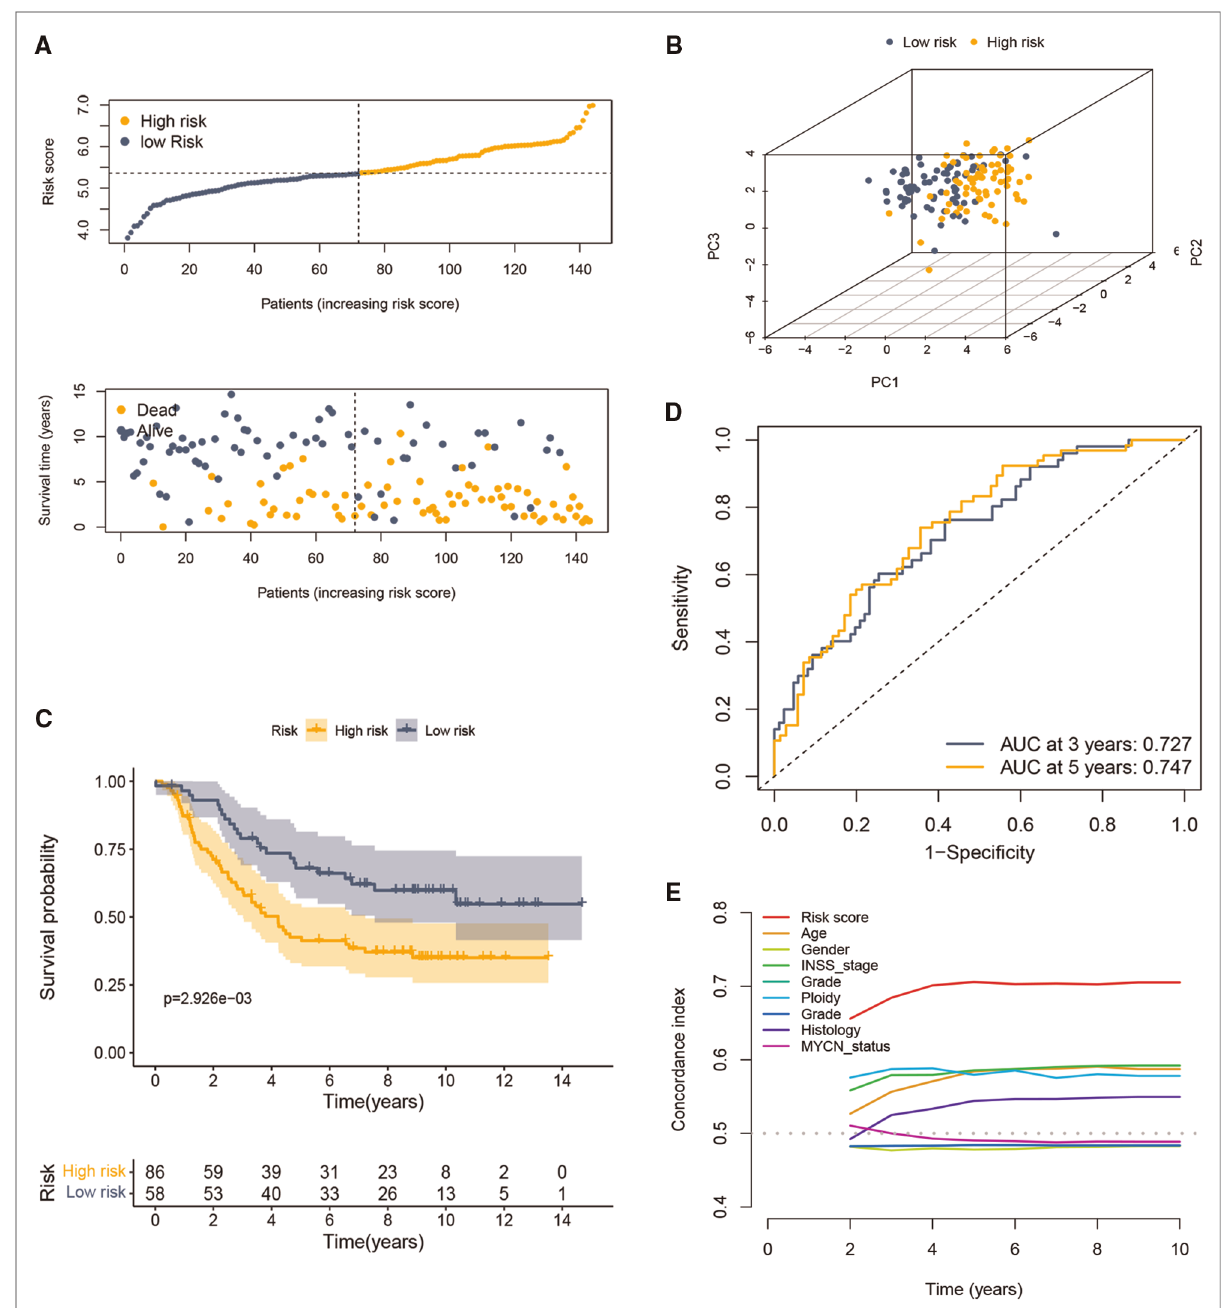
FIGURE 2 Validation of the cuproptosis-based signature in the testing set. ( A ) The distributions of OS status and patient survival status in the testing set. ( B ) PCA showed that the distribution of patients in two different risk groups is in two directions. ( C ) The Kaplan-Meier curves showed that signi fi cant differences were identi fi ed for OS between these two risk groups. ( D ) ROC curve at 3 and 5 years. ( E ) C-index of the risk score and other clinical